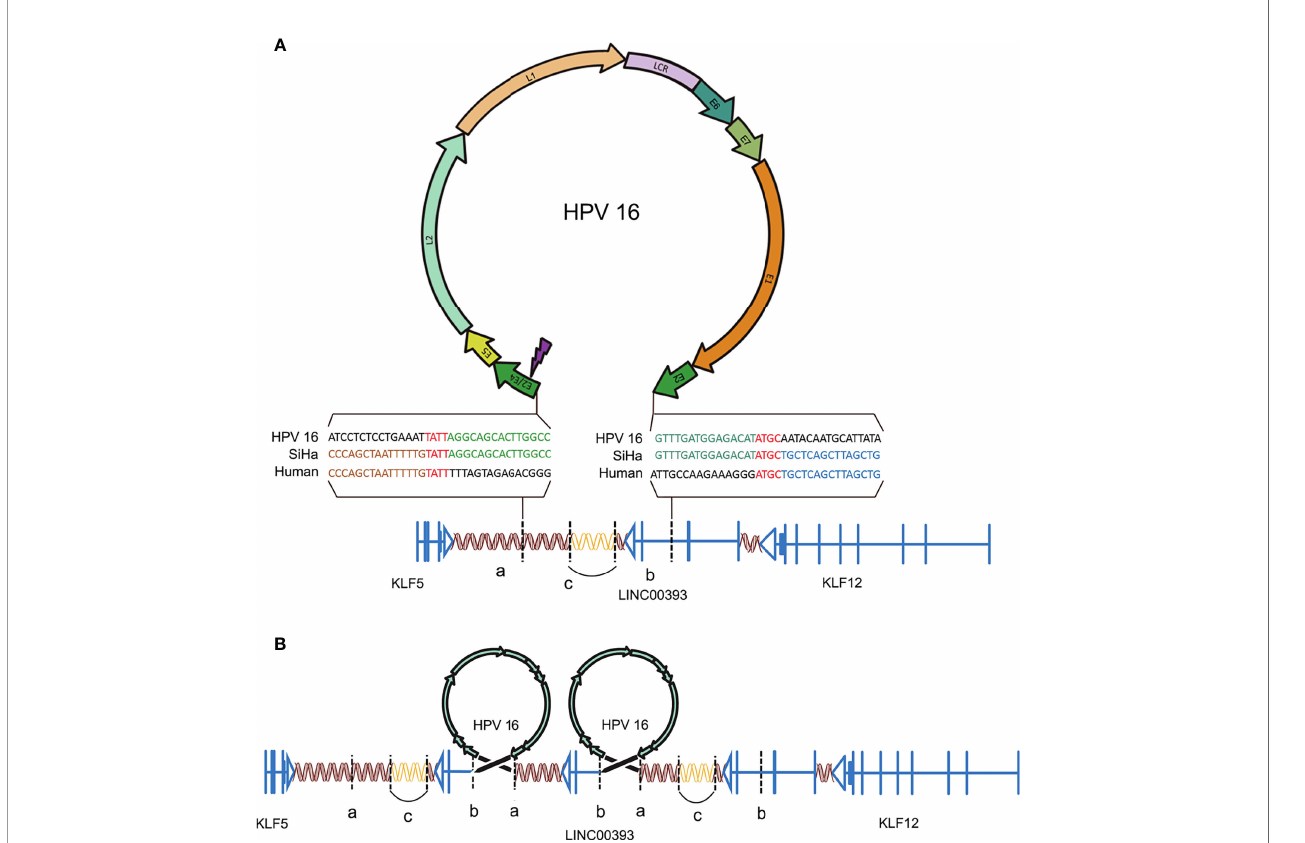
FIGURE 1 | HPV16 integration in LINC00393 in SiHa cells. (A) An overview of HPV and the integration region. Purple lightning indicates the breakage of E2/ E4. Double helix represents non-coding region, arrow represents the coding region, vertical line represents the exon, horizontal line represents intron and vertical dotted line represents the integration site. Gene model of HPV-LINC00393 integration (red ‘ TATT ’ and ‘ ATGC ’ indicate 5 ’ and 3 ’ micro-homologous fragments). (B) Structural variation of the integration region. Connected by HPV, the human genome between ‘ a ’ and ‘ b ’ contains a third exon, the second intron of LINC00393 and the desert gene are rearranged due to integration. The human genome, located between the two HPV genomes, lacks the C segment and is connected by itself (the sequence is represented with a blank double helix). ‘ a ’ means the integration site of 5 ’ ; ‘ b ’ means the integration site of 3 ’ ; ‘ c ’ means the lost gene segment during HPV16